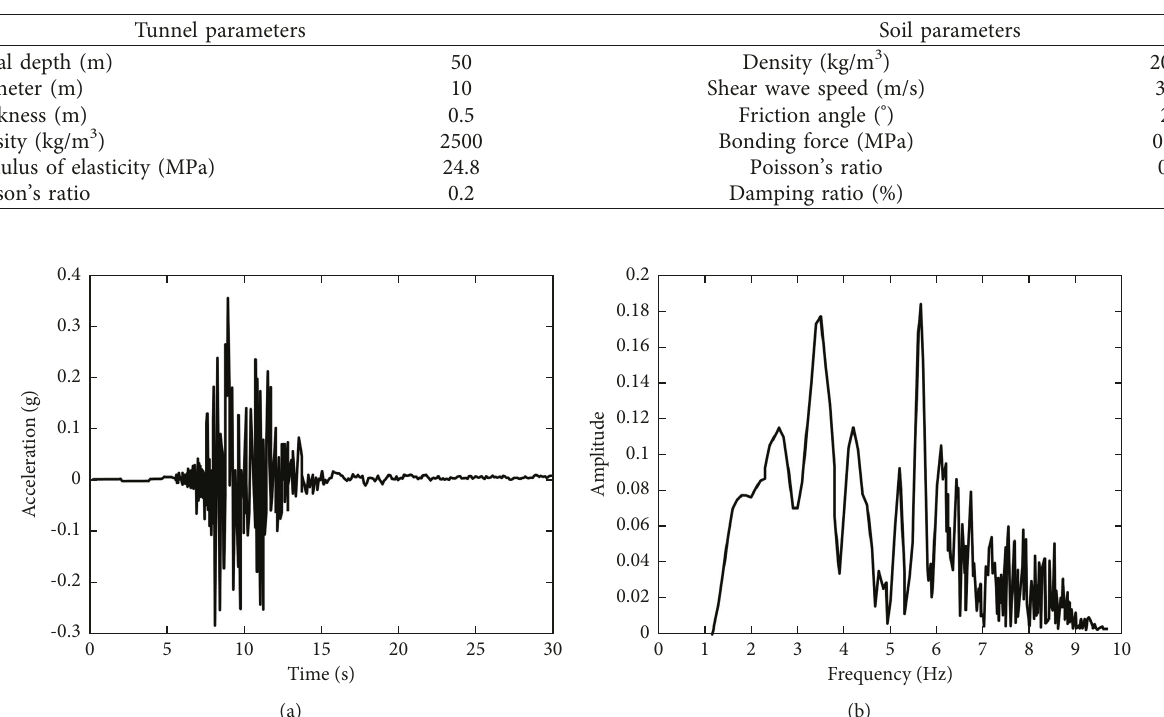
Figure 1: Model mesh of tunnel-soil. Table 1: Parameters of tunnel and